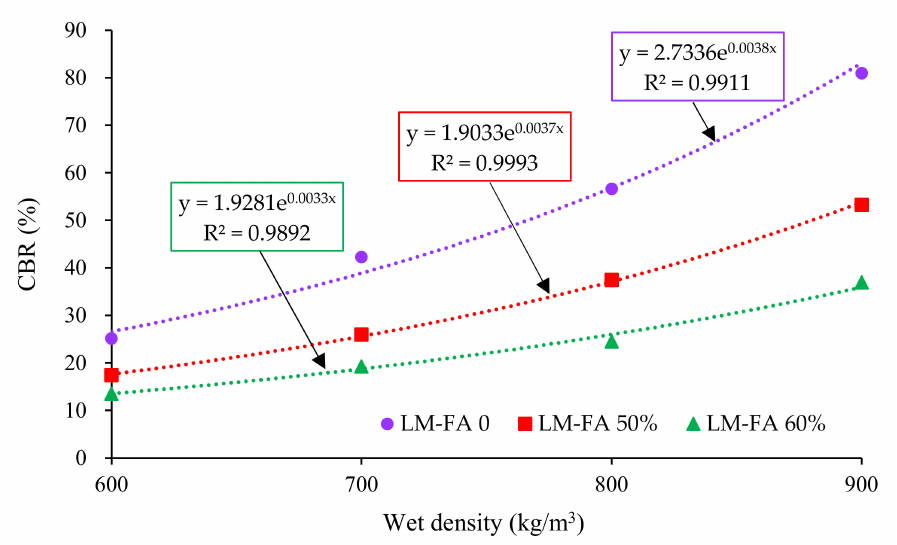
Figure 11. Relationship between the wet density and CBR of